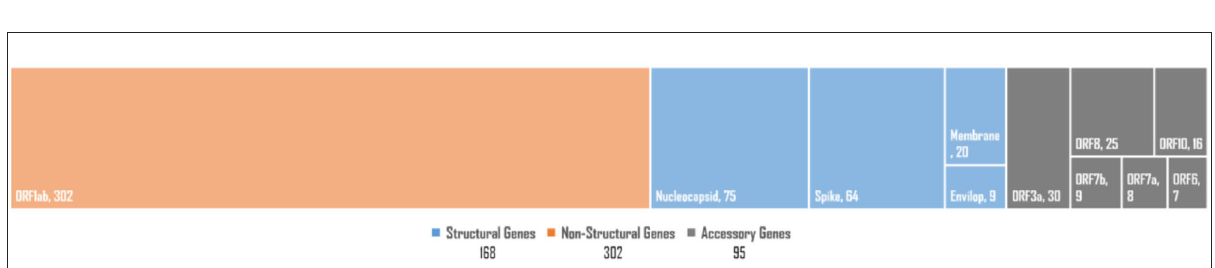
FIGURE2 The SARS-CoV-2 genome-wide distribution of all observed high-quality rcntSNVs. Structural protein-encoding genes category is shown in orange (left-most), non-structural protein-encoding genes category is represented in blue (in the middle), whereas accessory genes category is shown in gray blocks (right-most). In each category, the smaller blocks and their sizes represent genes in a particular category and their respective rcntSNVs load,